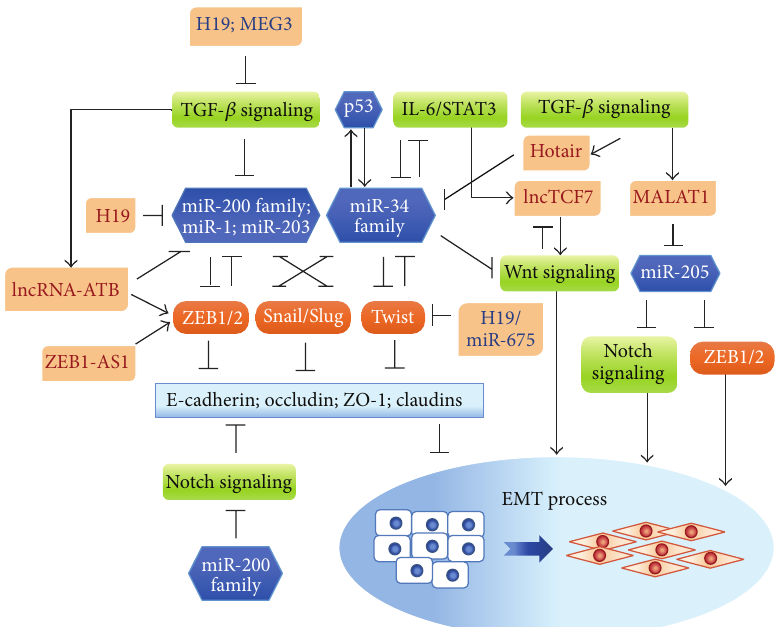
Figure 3: The molecular network composed of miRNAs/lncRNAs and EMT-TFs. miRNAs and lncRNAs form regulatory networks with EMT-TFs and EMT-associated signaling pathways that individually or cooperatively modulate EMT. EMT-suppressing miRNAs reciprocally suppress EMT-TFs and consequently downregulate the expression of epithelial markers. This negative feedback loop can be broken by TGF- 𝛽 or IL-6/STAT3 signaling, p53, and lncRNAs (e.g., H19, lncRNA-ATB, and ZEB-AS1). Dysregulation of these miRNAs and lncRNAs may lead to tumor